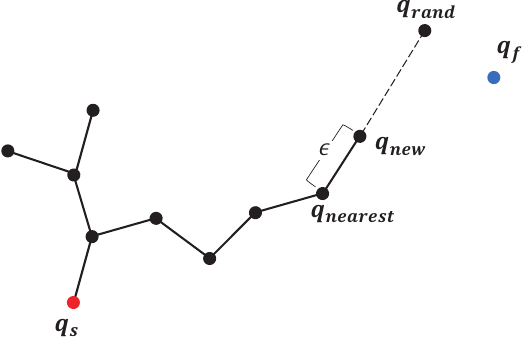
Figure 1. Illustration of the RRT